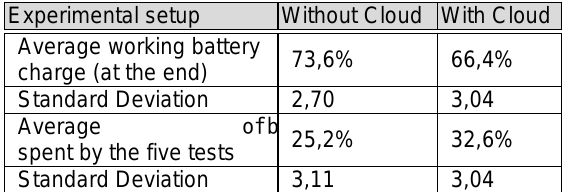
Table 2. Energy Consumption (as percentage of the battery full charge).